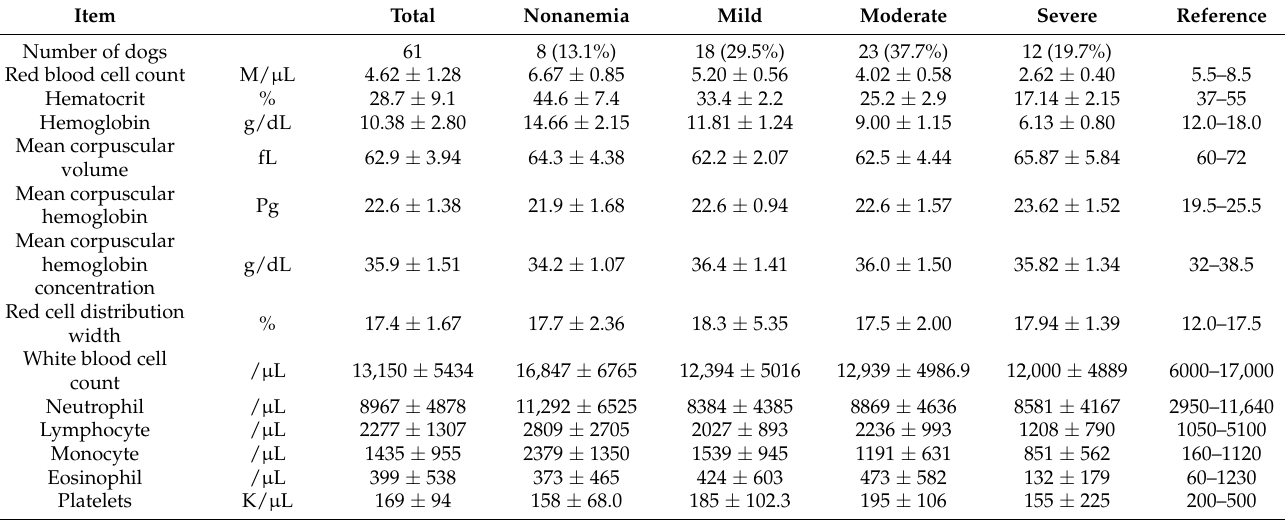
Table 3. Hematological variables recorded in 61 B. gibsoni infected